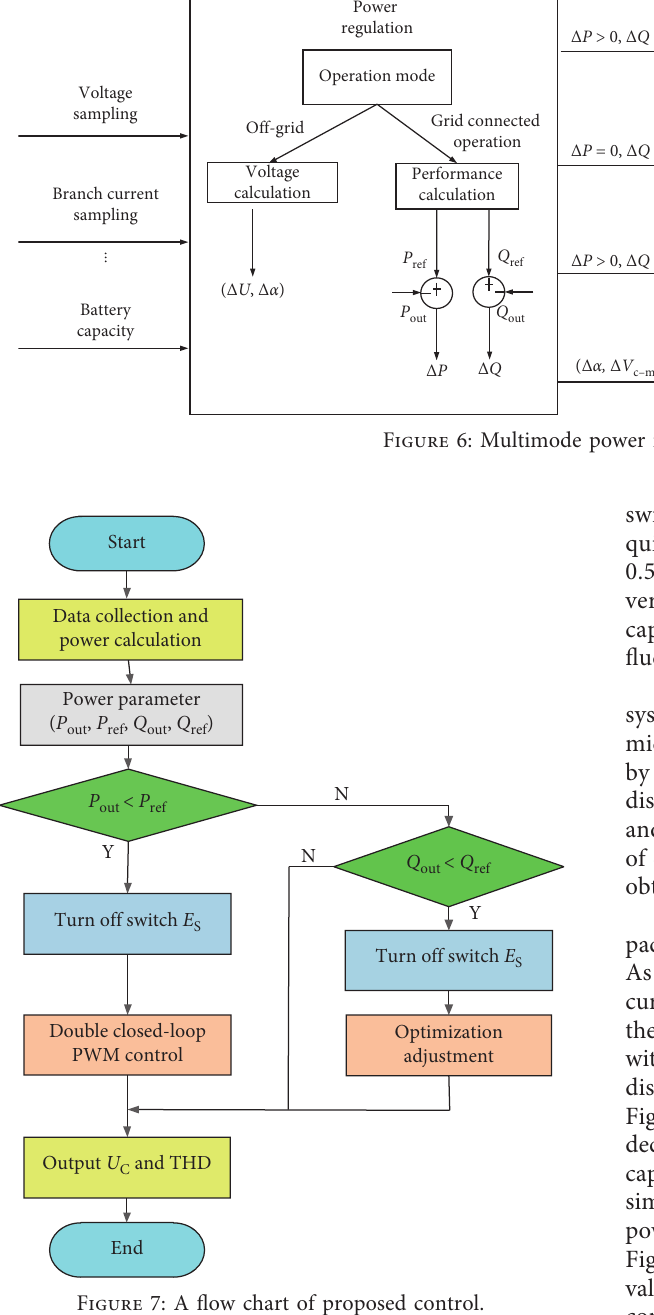
Figure 7: A flow chart of proposed